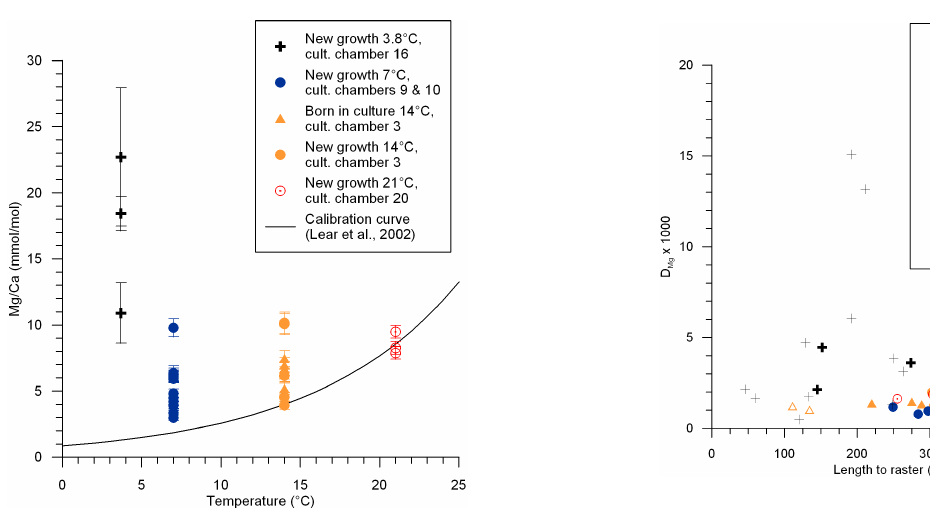
Fig. 8. Mg/Ca vs Temperature including Cibicidoides core top calibration of Lear et al. (2002), Mg/Ca= 0.867 ± 0.49exp (0.109+0.007 · BWT), where BWT is bottom water temperature).